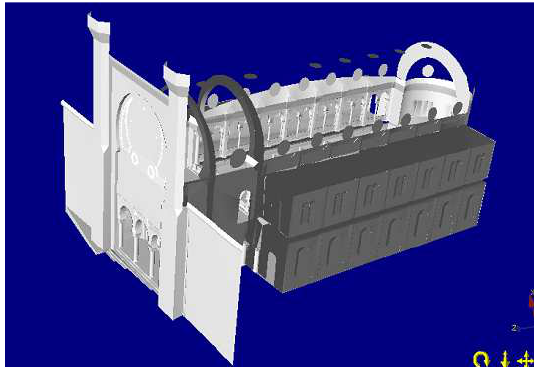
Figure 12. The result merged